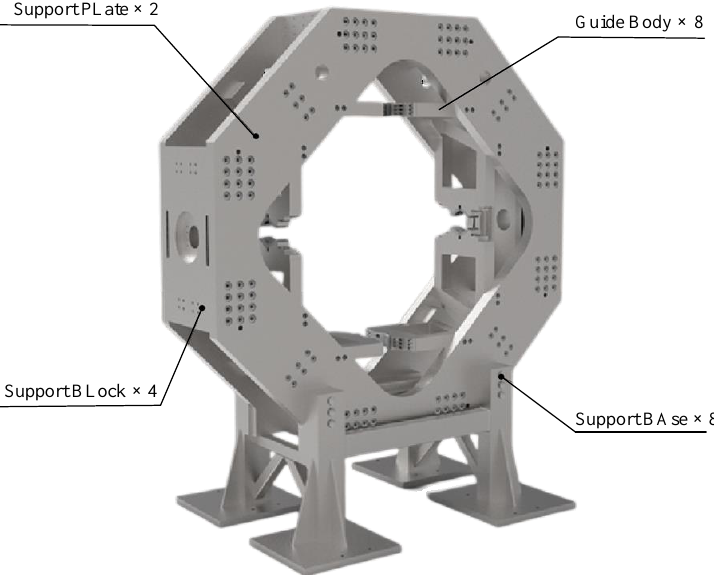
Figure 4. Composition of the high-temperature/biaxial loading module frame support.